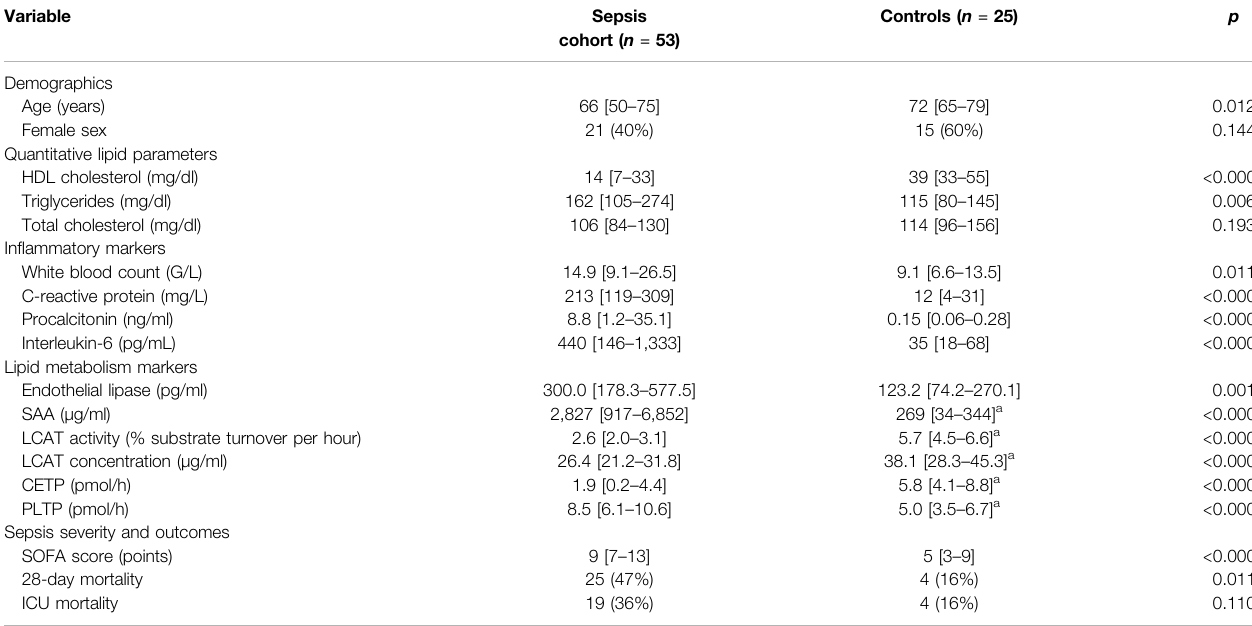
TABLE 1 | Baseline characteristics and lipid parameters in the ICU sepsis cohort ( n (cid:1) 53) and ICU control cohort ( n (cid:1) 25). As partially reported previously in Reisinger et al. (2020). Data are reported as medians [25th – 75th percentile], or absolute values and relative frequencies (%). Sepsis patients were ICU patients suffering from sepsis or septic shock. Controls were ICU patients without sepsis or bacteremia at the time of sample